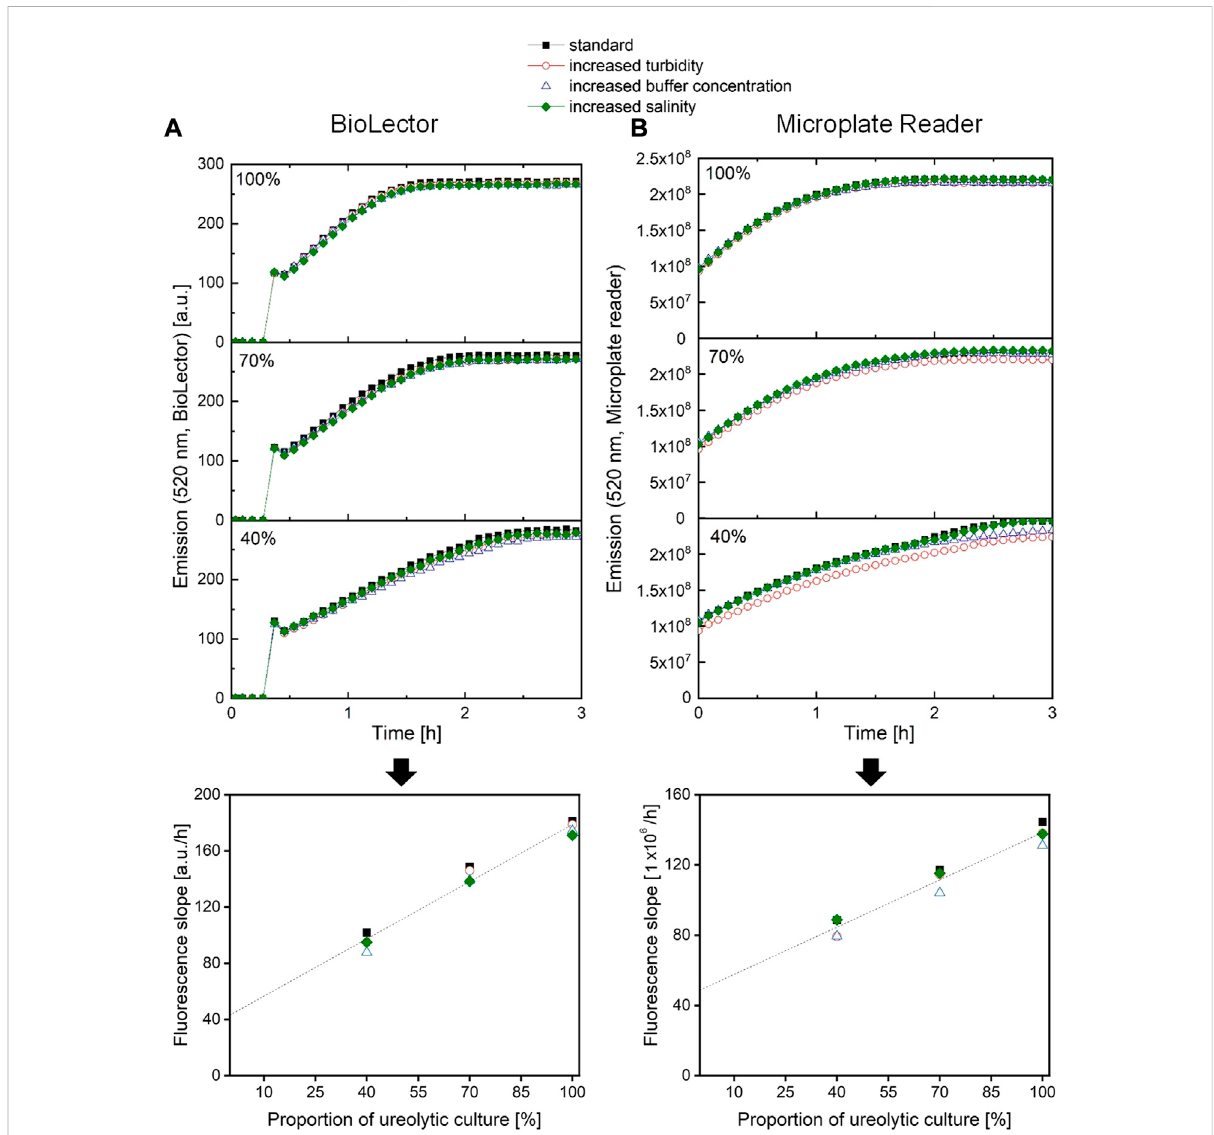
Fluorescence signals and their slope after sample addition for the same bacteria culture samples with different additives in order to increase sample turbidity, bufferconcentration or salinity, (A) using a BioLector I (BeckmanCoulter Life Sciences, Baesweiler) or (B) using amicroplate reader (SpectraMax iD3, Molecular Devices, United